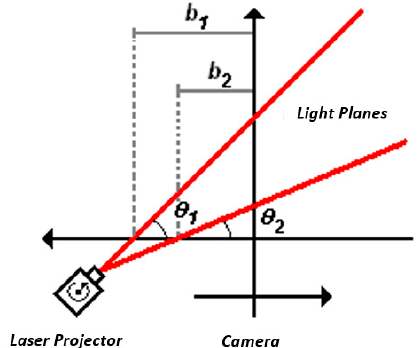
Figure 5. E ff ect of the misalignment of the mobile laser Figure 5. Effect of the misalignment of the mobile laser projector.